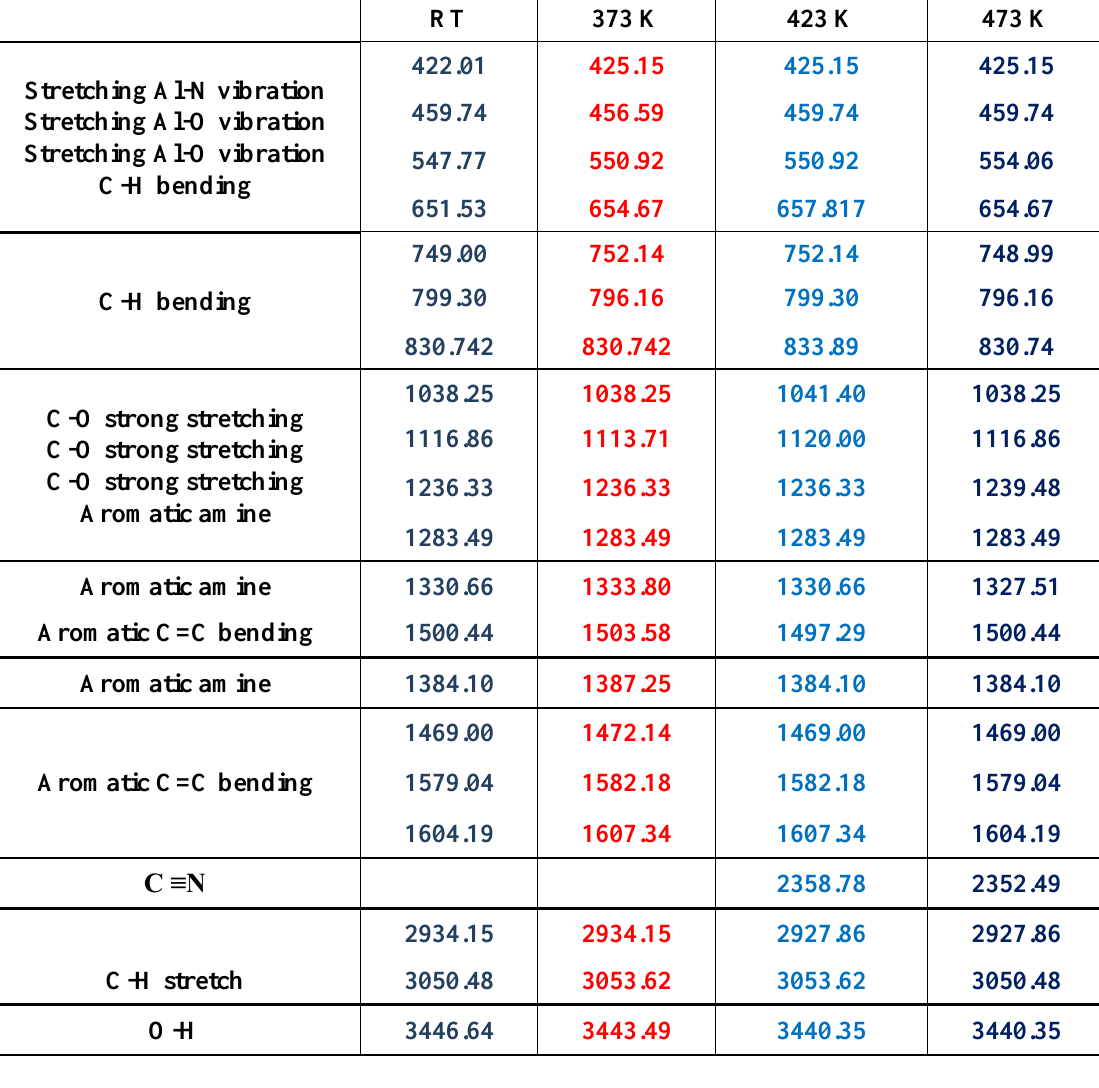
(100:10) treated with different annealing